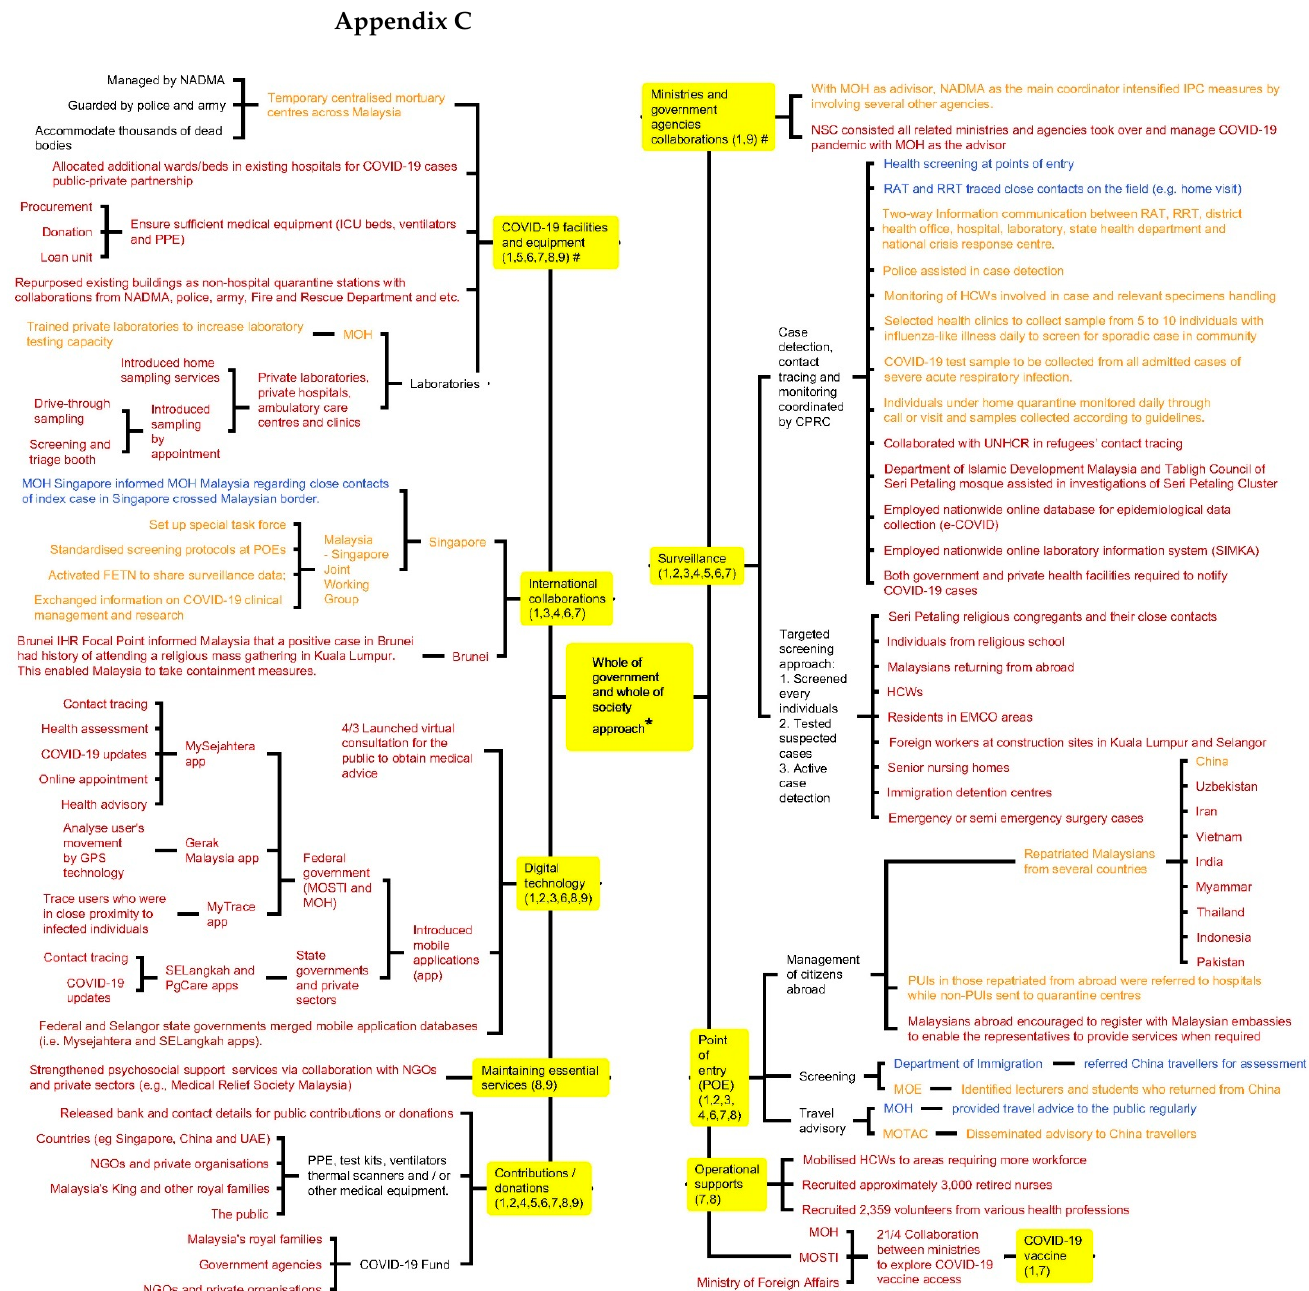
Figure A1. Whole of government and whole of society approach taken by Malaysia in response to the COVID-19 pandemic. # Numbers in parentheses denote WHO Pillars. * Measures implemented: (i) before the first wave (31 December to 24 January) indicated in blue, (ii) during the first wave (25 January–26 February) indicated in orange, and (iii) during the second wave (27 February onwards) indicated in red.